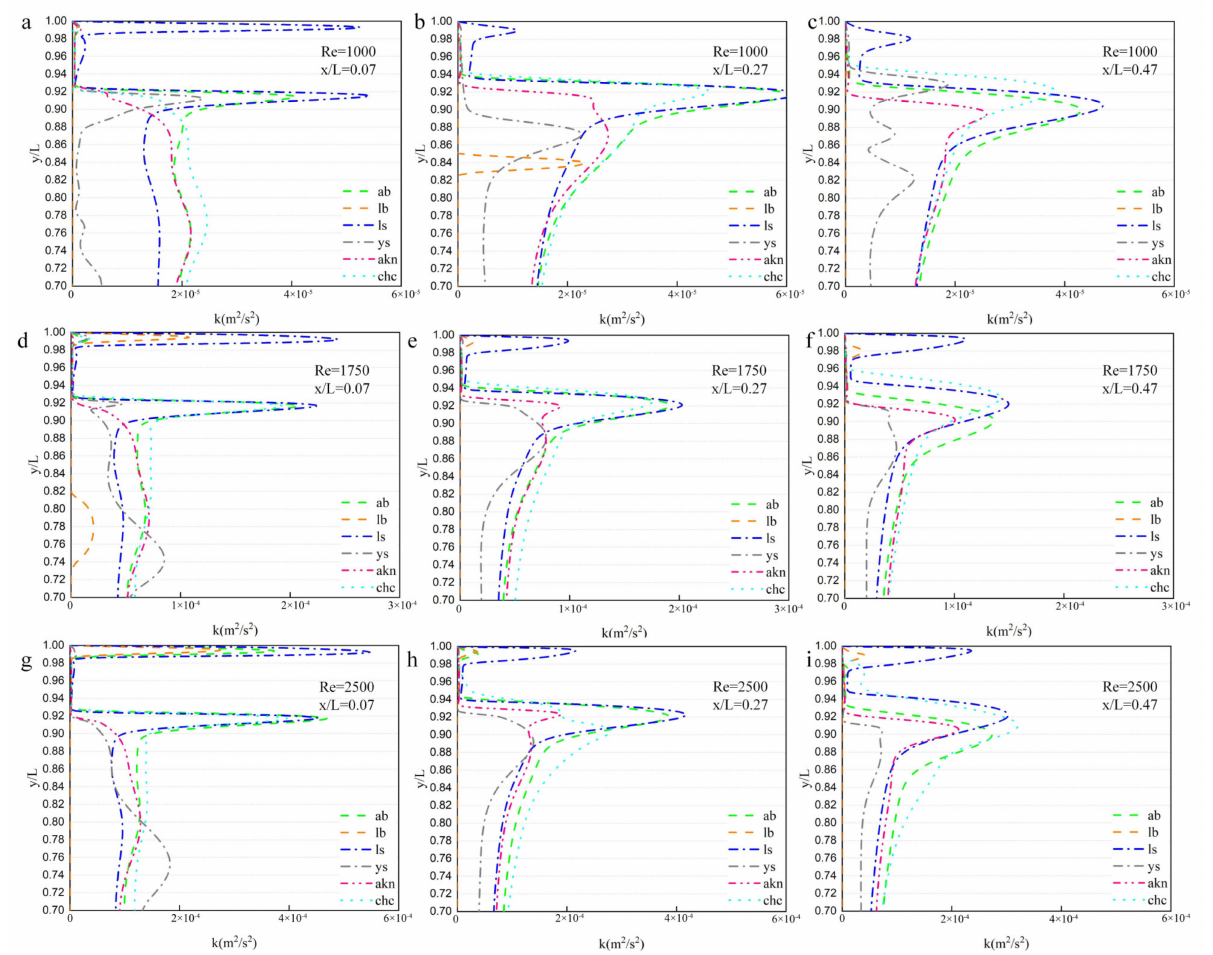
Figure 6. Comparison of turbulent kinetic energy profiles measured by PIV and modeled by six low-Reynolds number k- ε models. ( a ) Re = 1000, x/L = 0.07; ( b ) Re = 1000, x/L = 0.27; ( c ) Re = 1000, x/L = 0.47; ( d ) Re = 1750, x/L = 0.07; ( e ) Re = 1750, x/L = 0.27; ( f ) Re = 1750, x/L = 0.47; ( g ) Re = 2500, x/L = 0.07; ( h ) Re = 2500, x/L = 0.27; ( i ) Re = 2500, x/L =